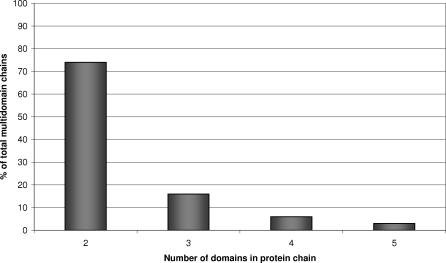
Percentage of Multidomain Chains with a Given Number of Component Domains